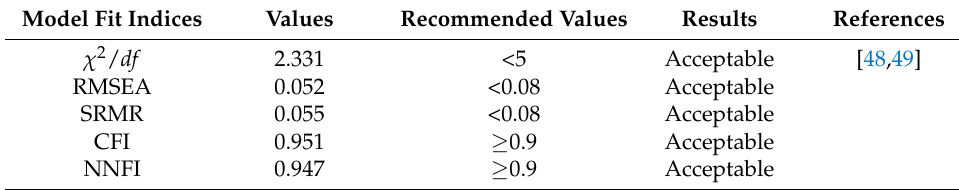
Table 6. Results of model fit indices for structural model.